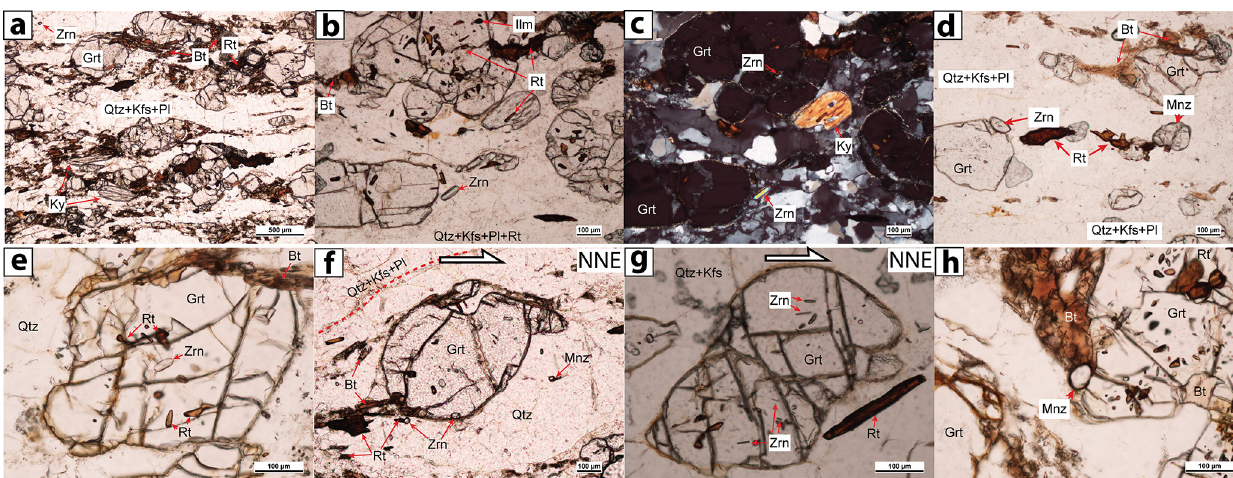
Figure 4. Granulite facies migmatitic paragneiss from the Sobrado middle tectonic slice (Fig. 2). (a) General microstructure where leucosome bands and preferred orientation of elongated garnets, biotite, rutile and kyanite define the foliation. (b) Zircon elongated grain in recrystallized leucosome domain. Main inclusions in garnet include rutile, ilmenite and zircon (PPL) and (c) cross-polarized light (CPL). (d) Monazite and zircon subrounded grain in the leucosome domain. (e) Subrounded elongated grain of zircon included in a garnet. (f) Plastically deformed garnet (sigmoidal grain) in a leucosome. Zircon and monazite are found in the quartz-rich area around the garnet. (g) Sigmoidal garnet in a leucosome. Inclusions of prismatic and bipyramidal zircons and rutile are observed. (h) Monazite grain in a garnet pressure shadow